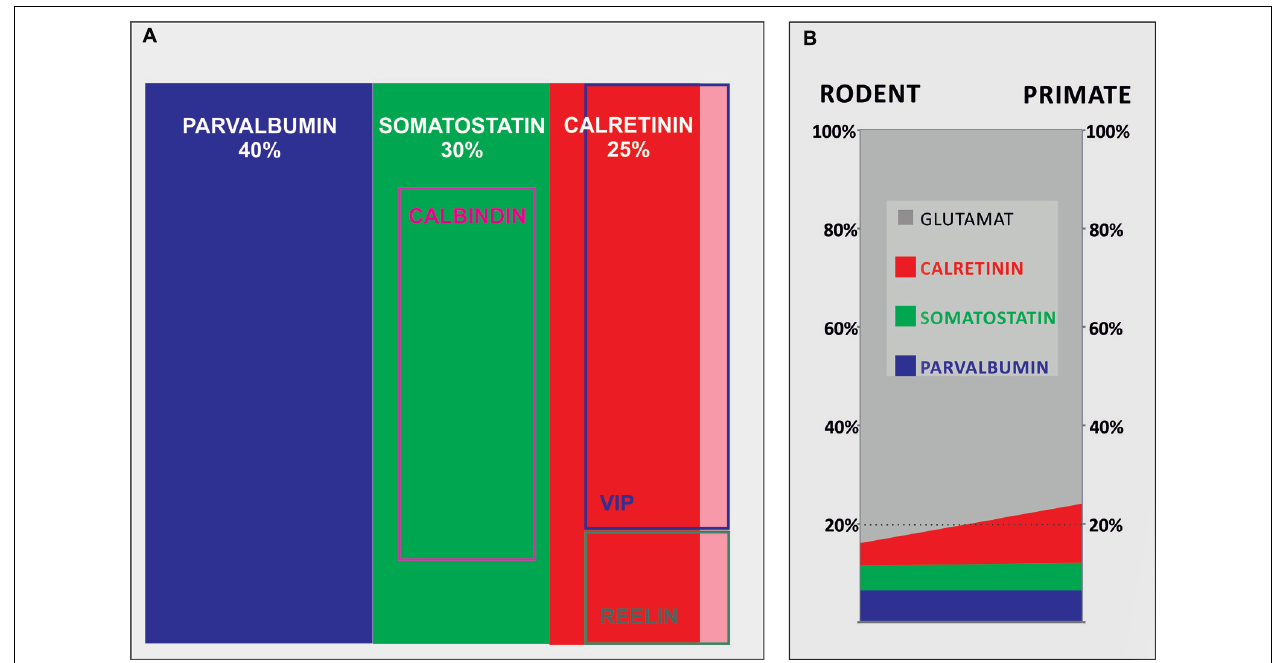
comprise more than 90% of all GABAergic neurons. (B) Demonstrates 50% of increase of the contribution of cortical GABAergic neurons from rodents ( ≈ 16%) to primates ( ≈ 24%), which can be attributed to threefold increase in number of calretinin neurons (shown in red; from ≈ 4% in rodents to ≈ 12% of the total neuron number in